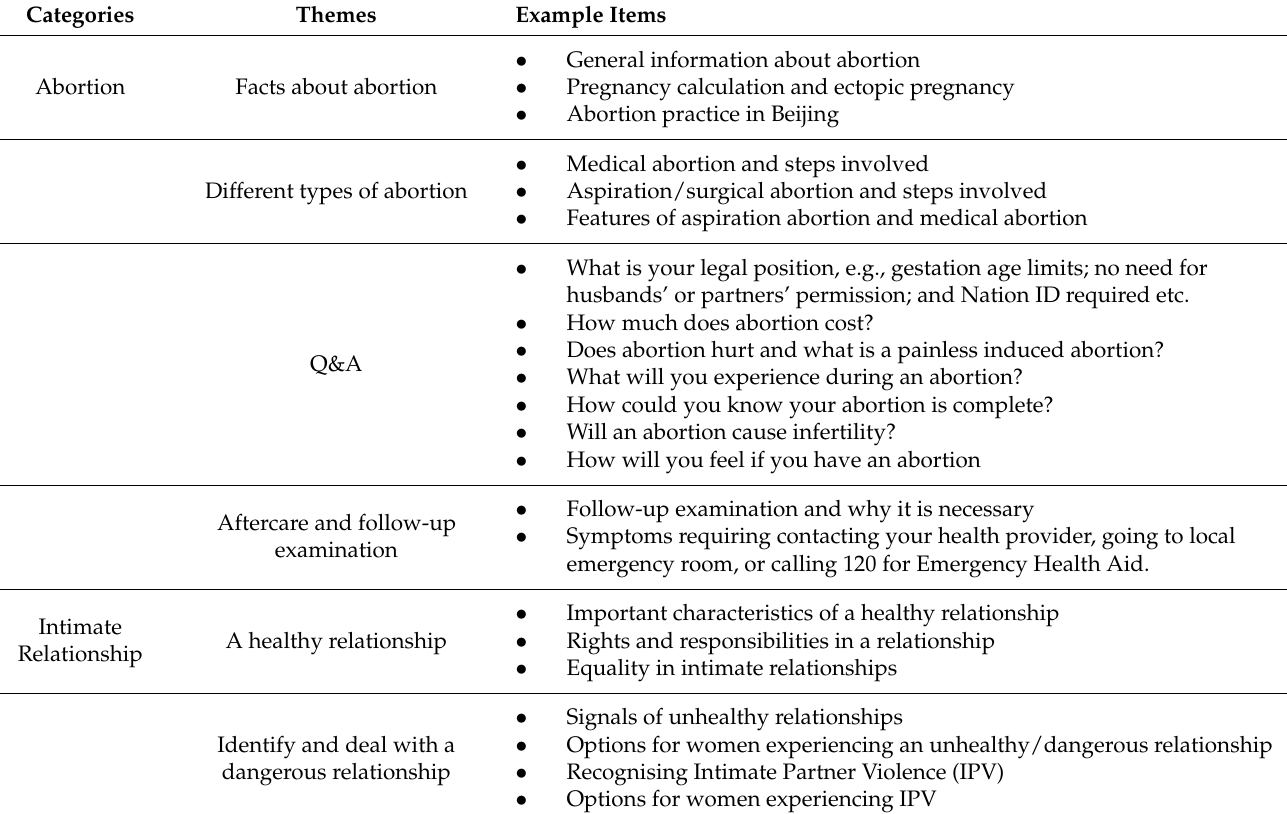
Table 2. Content of the information booklet and